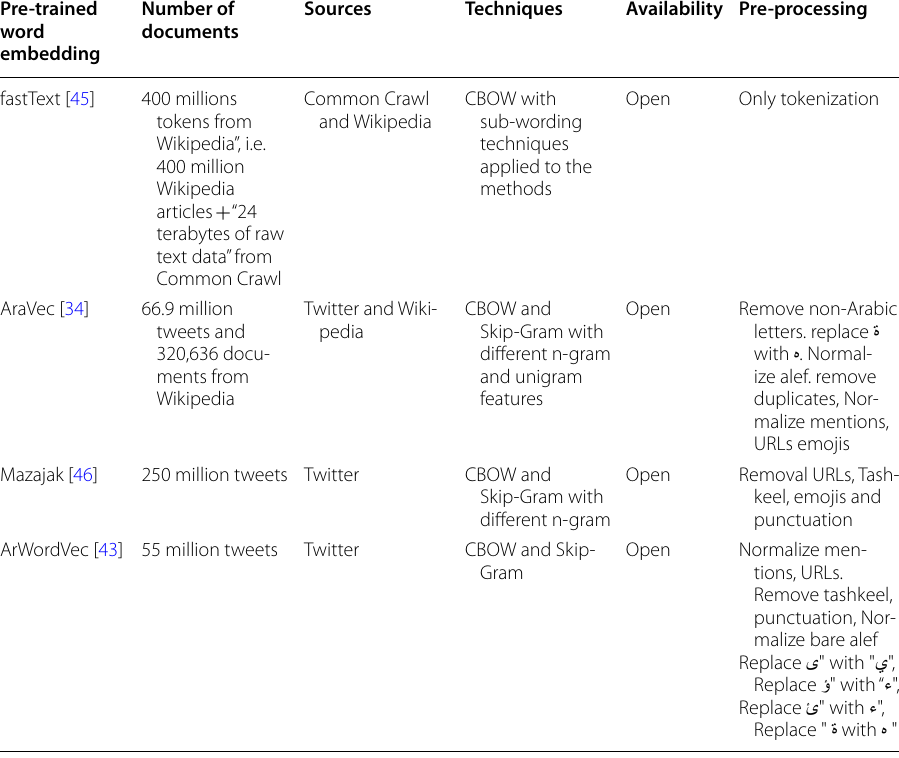
Table 1 Pre-trained word embedding models Pre-trained Number of word embedding